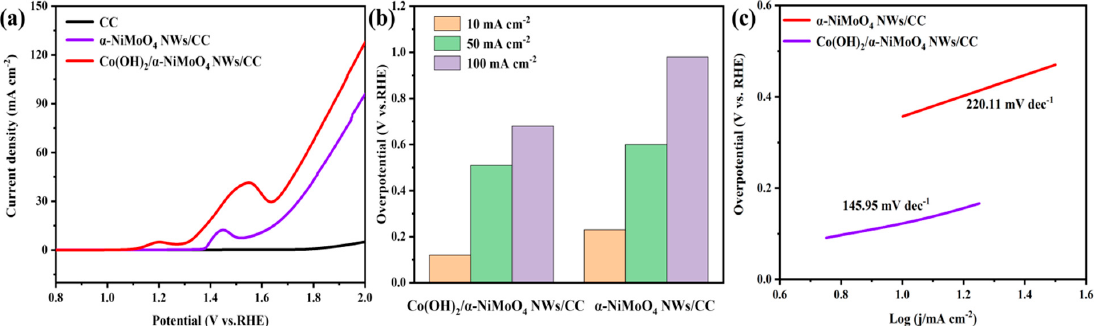
Figure 6. ( a ) LSV curves of different catalysts for OER; ( b ) the overpotential for α‐ NiMoO 4 NWs/CC and Co(OH) 2 / α‐ NiMoO 4 NWs/CC to reach different current densities of OER; ( c ) Tafel curves of α‐ NiMoO 4 NWs/CC and Co(OH) 2 / α‐ NiMoO 4 NWs/CC. The C dl of the Co(OH) 2 / α‐ NiMoO 4 NWs/CC electrode was studied in the non ‐ Faraday region to further investigate the reason for the high electrocatalytic activity of the Co(OH) 2 / α‐ NiMoO 4 NWs/CC electrocatalyst. The C dl was estimated by recording a series of cyclic voltammograms of the α‐ NiMoO 4 NWs/CC (Figure 7a) and Co(OH) 2 / α‐ NiMoO 4 NWs/CC (Figure 7b) electrocatalysts at varied scanning rates of 10~120 mV s − 1 in the scanning range of 0.82~0.94 V vs. RHE. As shown in Figure 7c, the C dl of the Co(OH) 2 / α‐ NiMoO 4 NWs/CC electrocatalyst is 41.09 mF cm − 2 , which is approximately 1.67 times that of α‐ NiMoO 4 NWs/CC (C dl is 24.6 mF cm − 2 ). The results indicate that the Co(OH) 2 / α‐ NiMoO 4 NWs/CC electrocatalyst performs better regarding electrocatalytic oxygen evolution. As shown in Figure 7d, the lowest R ct value of Co(OH) 2 / α‐ NiMoO 4 NWs/CC implies lower charge transfer resistance and faster electron transport, which improves OER kinetics.